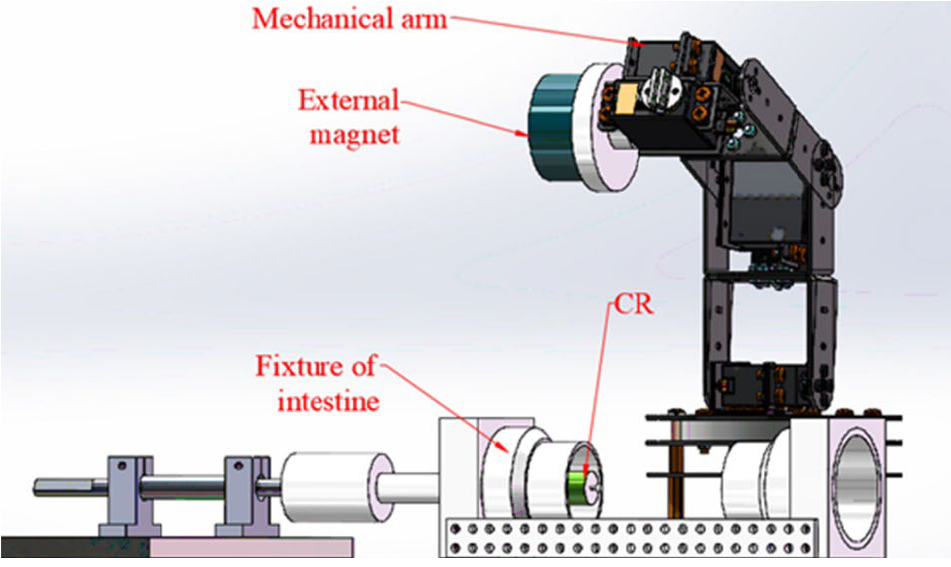
Figure 6. Biopsy experiment system.